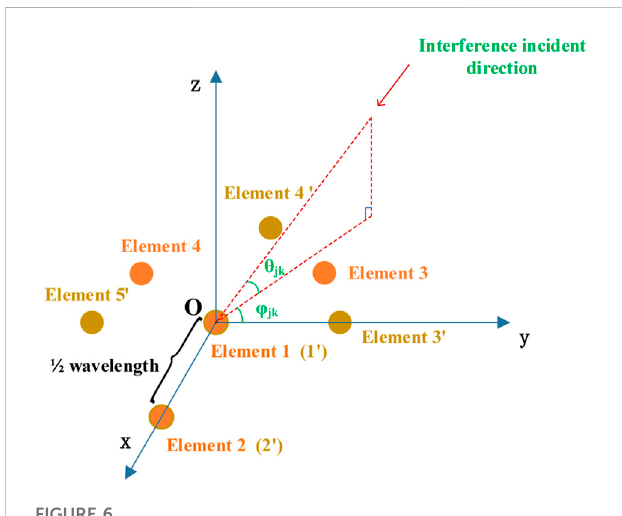
FIGURE 6 Position of array element in Oxyz coordinate system.